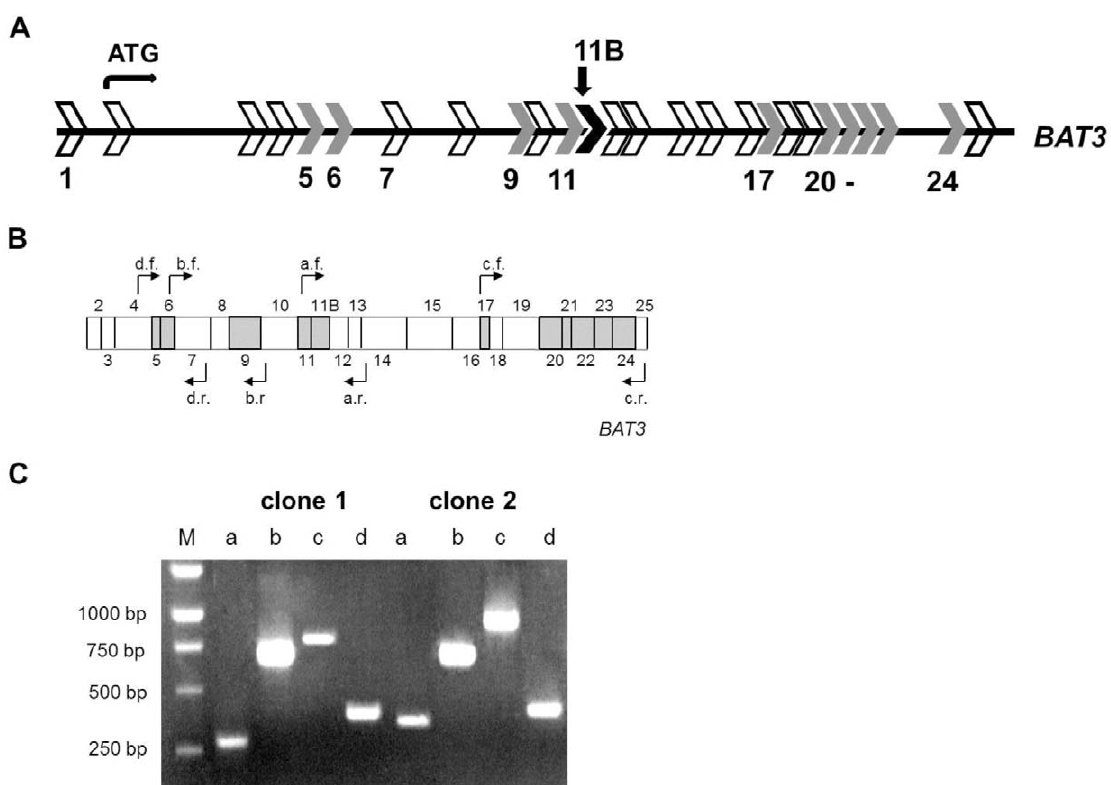
Figure 1. Detection of exon sequences in BAT3 cDNA clones by PCR. A. Exon-intron-structure of the BAT3 gene. Exon sequences are indicated as arrows. The start codon for translation in exon 2 is indicated. Potentially spliced exons are numbered. Exon 1 and 7 exist in different fragment lengths, 247 bp or 271 bp for exon 1 (NCBI) and 236, 254 or 278 bp for exon 7 (NCBI, ENSEMBL). Exons highlighted in grey could be deleted without changing the reading frame. The novel exon 11B with a length of 108 bp is labeled by arrow. Exon 11B also can be deleted without a change of the reading frame of the adjacent exon sequences. B. Schematic presentation of BAT3 cDNA. Exon boundaries are indicated and protein-encoding exons are numbered from 2 to 25. Potentially spliced exons are highlighted in grey. The position of complementary primer pairs (a to d) for forward (f) and reverse (r) PCR are indicated by arrows. C. Primers indicated in B were used to characterize BAT3 cDNA clones. Digestion of two BAT3 cDNAs is shown for example. Lane M contains size standards with bp indicated on the left. Lanes a: PCR products of clones 1 and 2 exhibit a band of 280 bp (no exon 11B) or of 380 bp (with exon 11B). Lanes b: Both clones generate a PCR product of 660 bp, indicating the presence of exon 9. Lanes c: The sizes of PCR fragments from clone 1 and clone 2 are 800 bp or 950 bp, respectively. This size is consistent with the presence or absence of exon 24. Lanes d: The presence of exon 5 is verified in clones 1 and 2 by a PCR product of 400 bp.